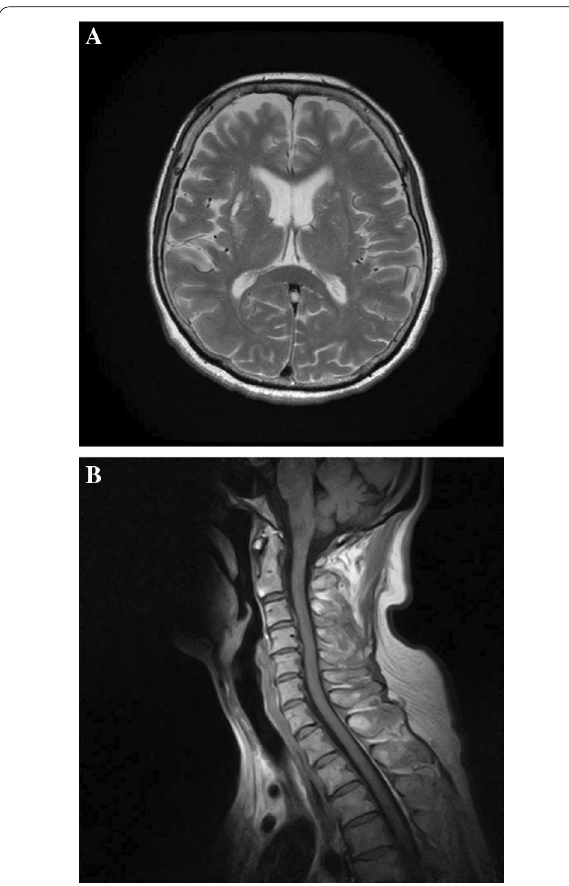
Fig. 2 Magnetic resonance imaging. A Brain magnetic resonance imaging (MRI). Brain MRI shows multiple T2 high signals in the bilateral basal ganglia and cerebral white matter, indicating a chronic ischemic lesion. There is no evidence of brain metastasis. B Spinal MRI. C4 kyphosis and narrowing of the spinal canal of C4/5. No obvious spinal cord compression or abnormal signal is observed